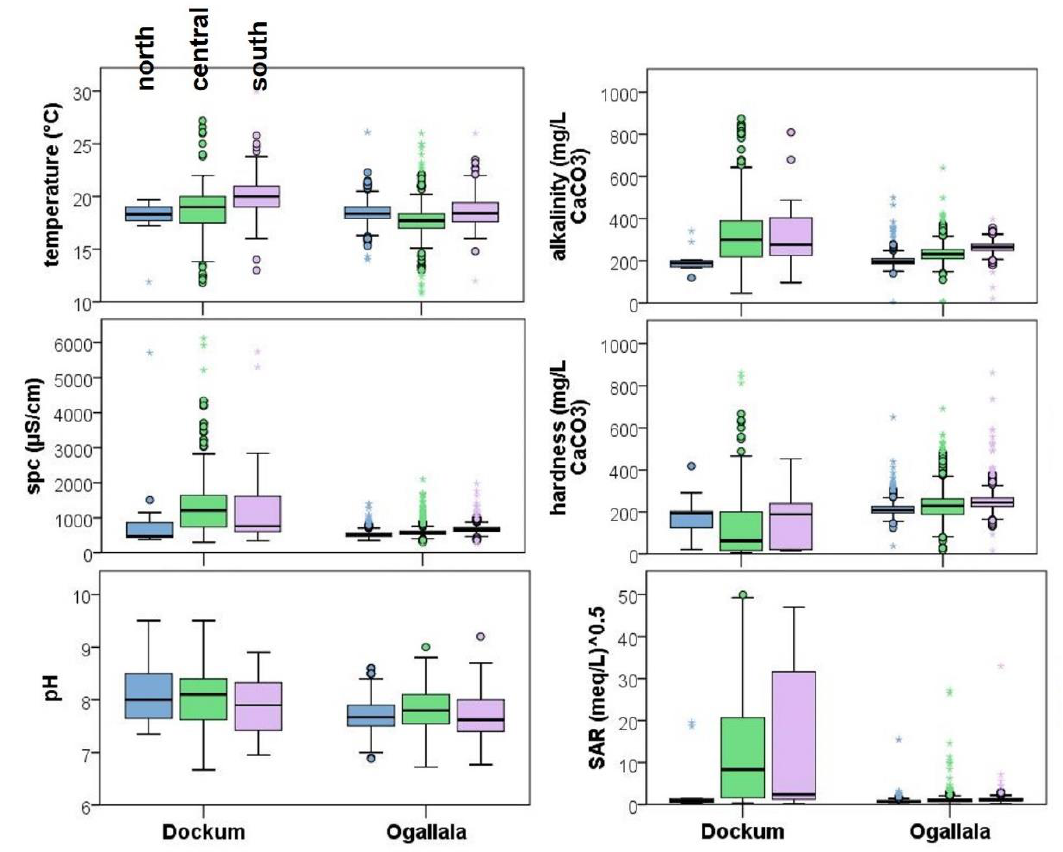
Figure 7. Water quality indicator distributional comparison between Ogallala and Dockum aquifers from 1990 to 2021. County-based spatial groupings indicated by color where blue, green, and purple indicate north → central → south spatial trends within northern Dockum Aquifer.